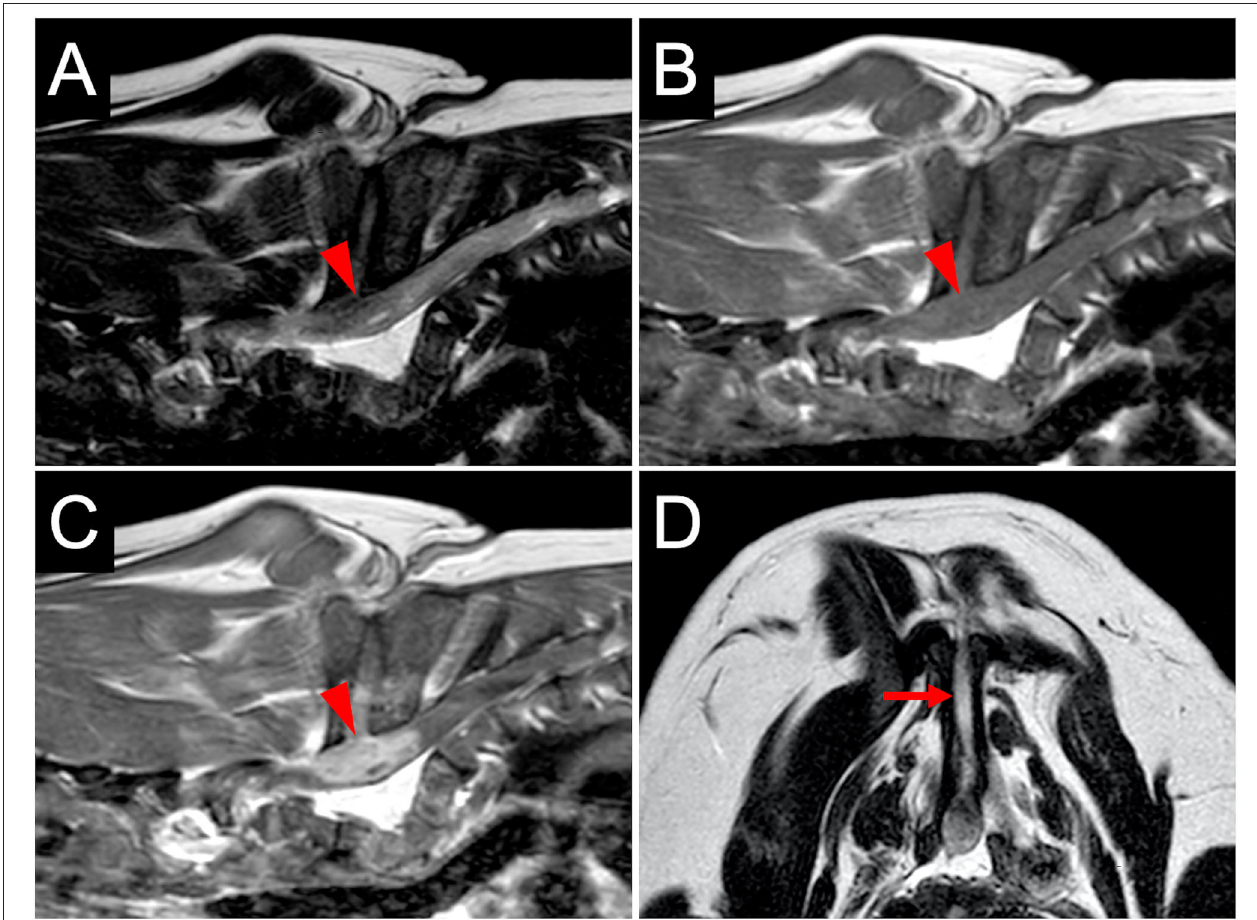
FIGURE 2 | MR images at diagnosis. The spinal cord at the level of T5–T6 vertebrae (arrowheads) is hypointense on T2-weighted sagittal imaging (A) and isointense on T1-weighted sagittal imaging (B) . T1-weighted post-contrast sagittal imaging (C) shows the enhanced lesion in the spinal cord with contrast medium. Transverse T2-weighted imaging at the level of T5–T6 (D) shows a sinus tract (arrow) in the fused spinous